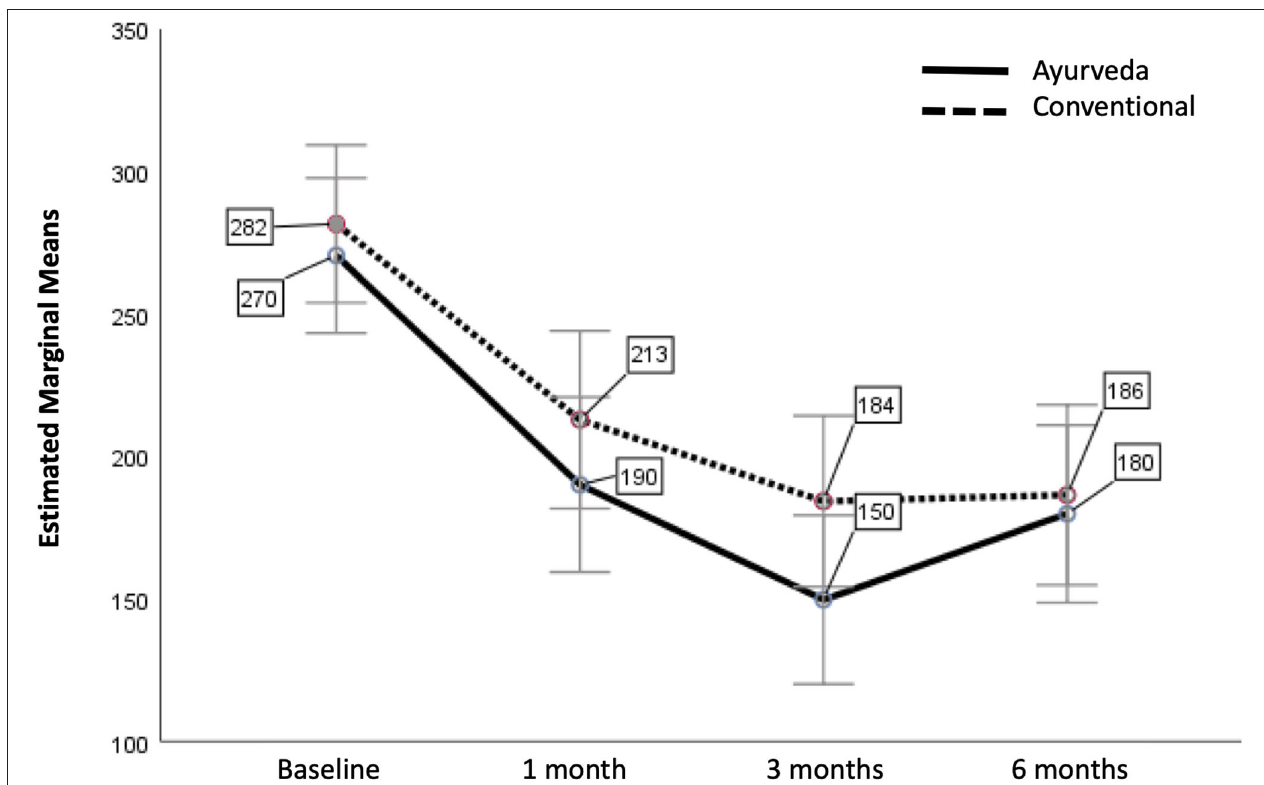
FIGURE 2 | Estimated Marginal Means of IBS-SSS with patients’ expectations as covariate (with error bars 95% confidence interval). The covariate patients’ expectations is evaluated at the value 6.57 (adjusted